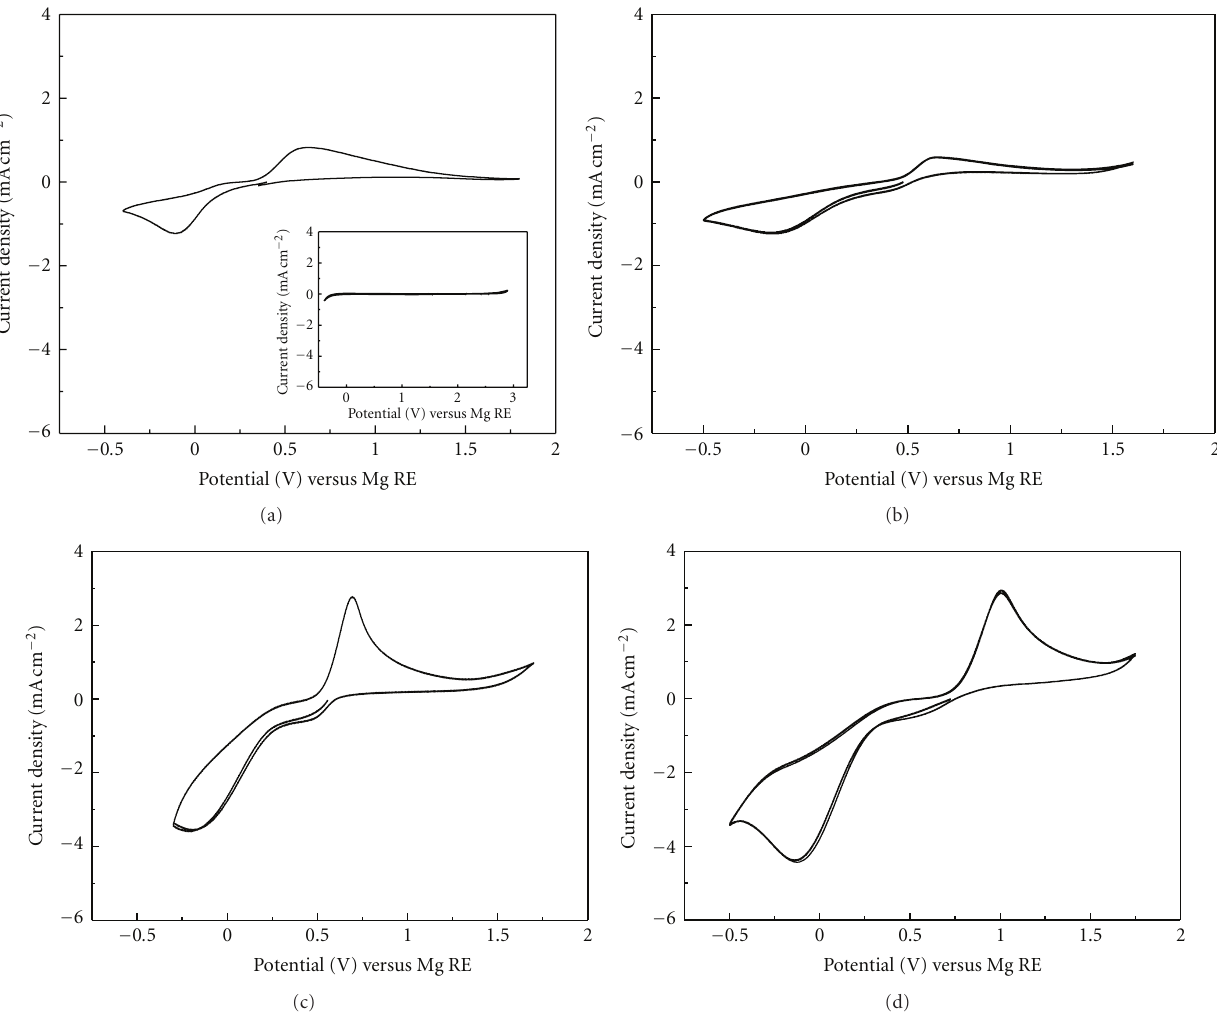
Figure 4: Typical cyclic voltammograms of Mg deposition-dissolution on Pt disk electrode from (a) 0.3 molL − 1 Mg(CF 3 SO 3 ) 2 /BMImBF 4 , inset is the CV of BMImBF 4 , (b) 0.3molL − 1 Mg(CF 3 SO 3 ) 2 /BMImBF 4 + THF (6:1), (c) 0.3 molL − 1 Mg(CF 3 SO 3 ) 2 /BMImBF 4 + THF (3:1), and (d) 0.3molL − 1 Mg(CF 3 SO 3 ) 2 /BMImBF 4 + THF (1: 1). The scanning rate was 50mVs − 1